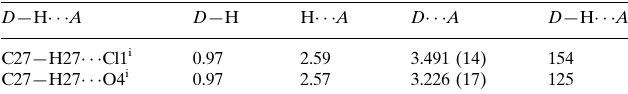
Hydrogen-bond geometry (A˚ , (cid:2)